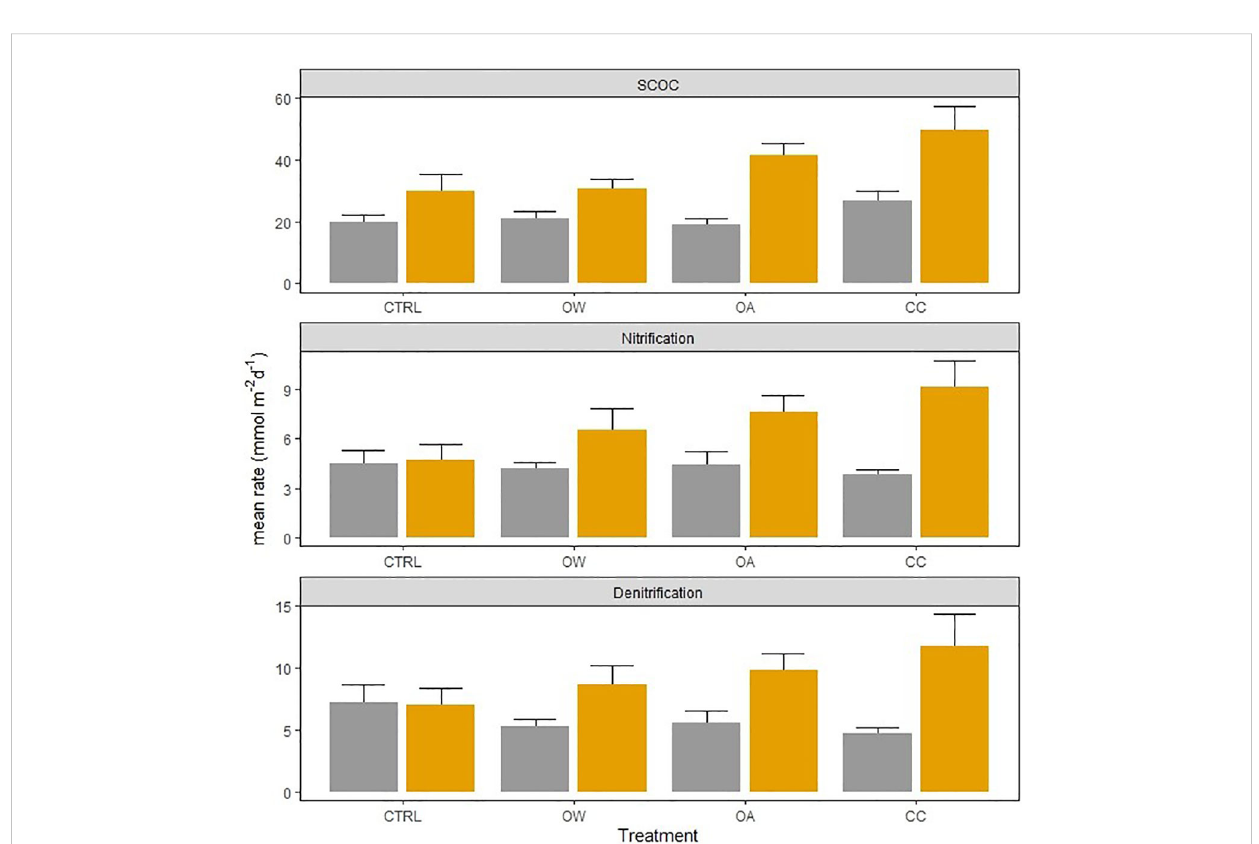
FIGURE 3 Effect of Lanice conchilega presence (present: orange bars, absent: grey bars) on sediment community oxygen consumption (SCOC, mmol O 2 m -2 d -1 ), nitri fi cation, and denitri fi cation rates (mmol N m -2 d -1 ), in 4 different treatments, with different times pooled because experiment duration did not affect the fl uxes and processes. Error bars represent standard errors (±